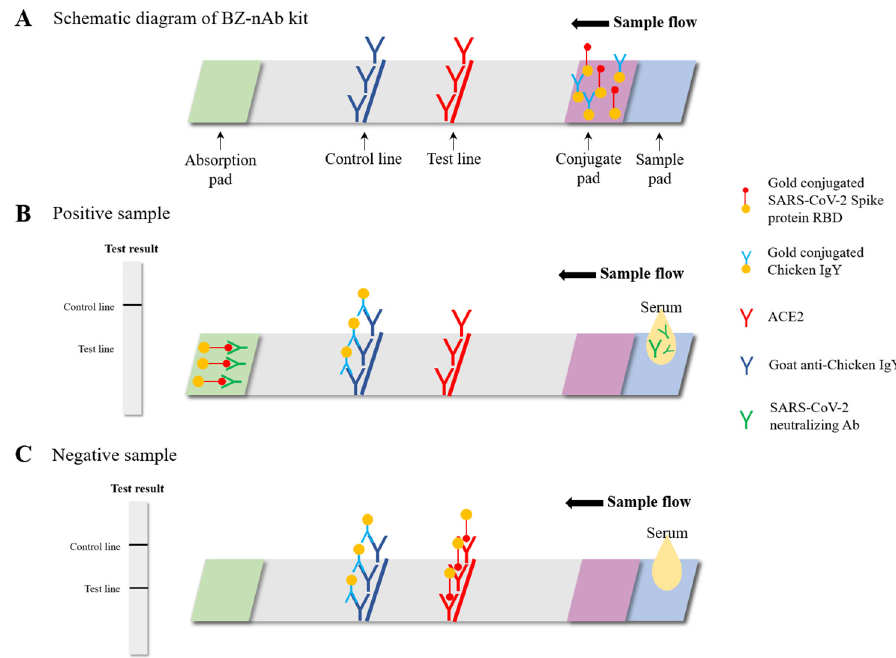
Figure 1. BZ-nAb test kit. ( A ) Schematic diagram of the BZ-nAb is shown. The diagram of SARS- CoV-2 neutralizing antibody positive ( B ) and negative ( C ) samples. In SARS-CoV-2 nAb positive samples, the RBD-ACE2 interaction in the test line are inhibited by nAbs in the sample, and vice versa in the negative sample.